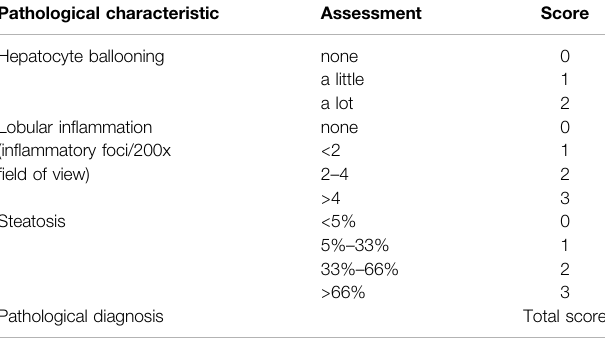
TABLE 1 | The scoring criteria of